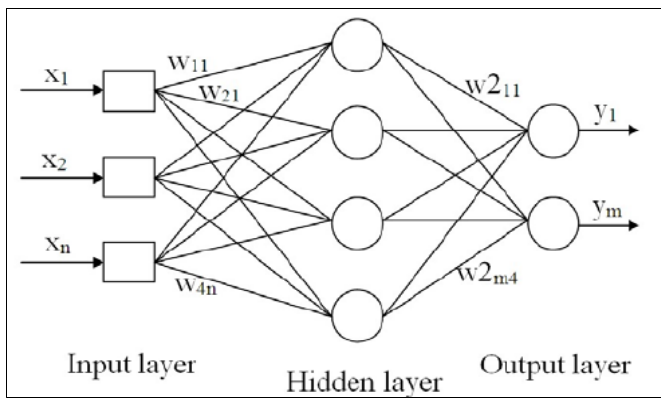
Figure 4: MLP Neural Networks